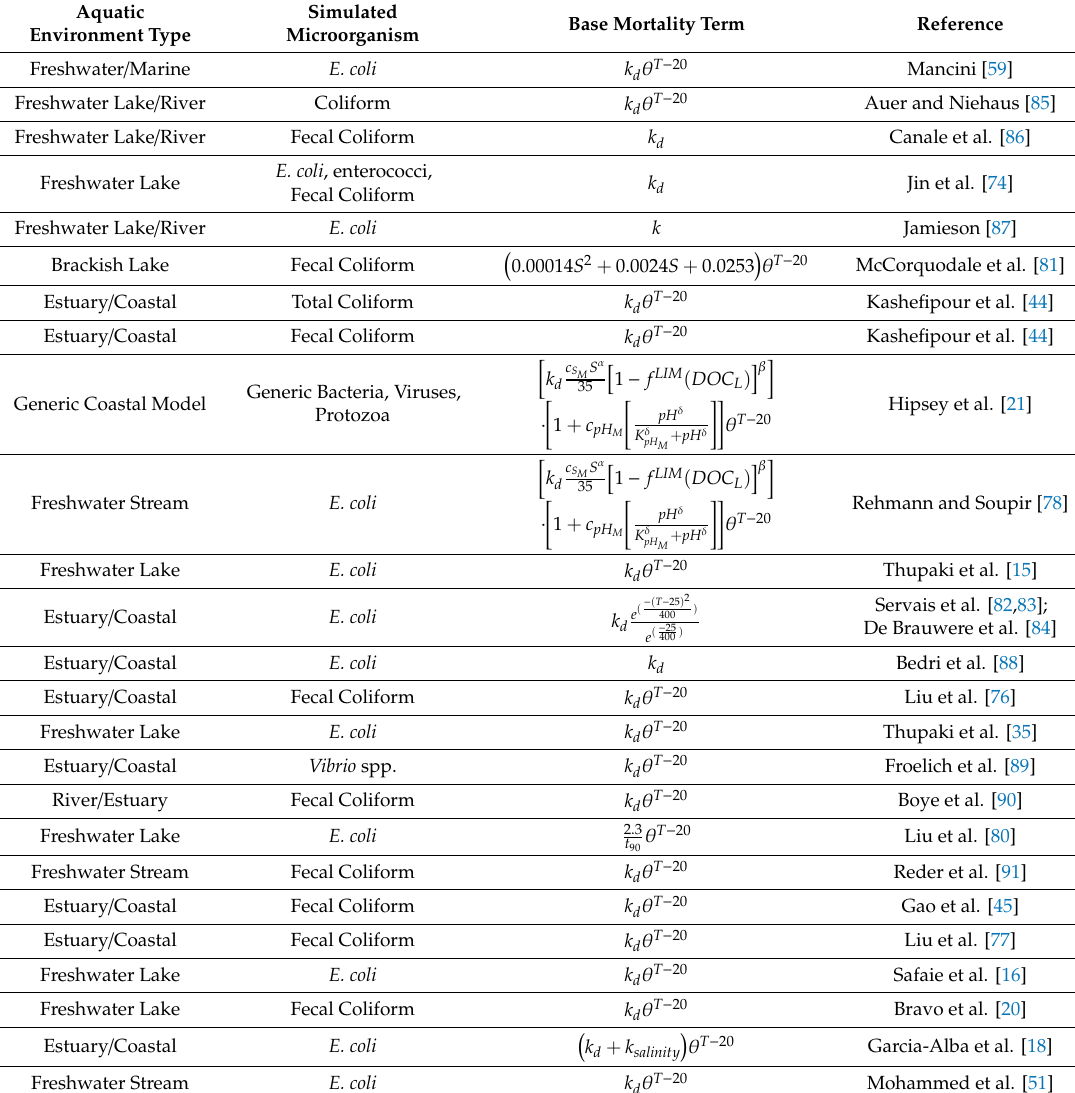
Table 1. Base mortality terms used in contaminant fate and transport